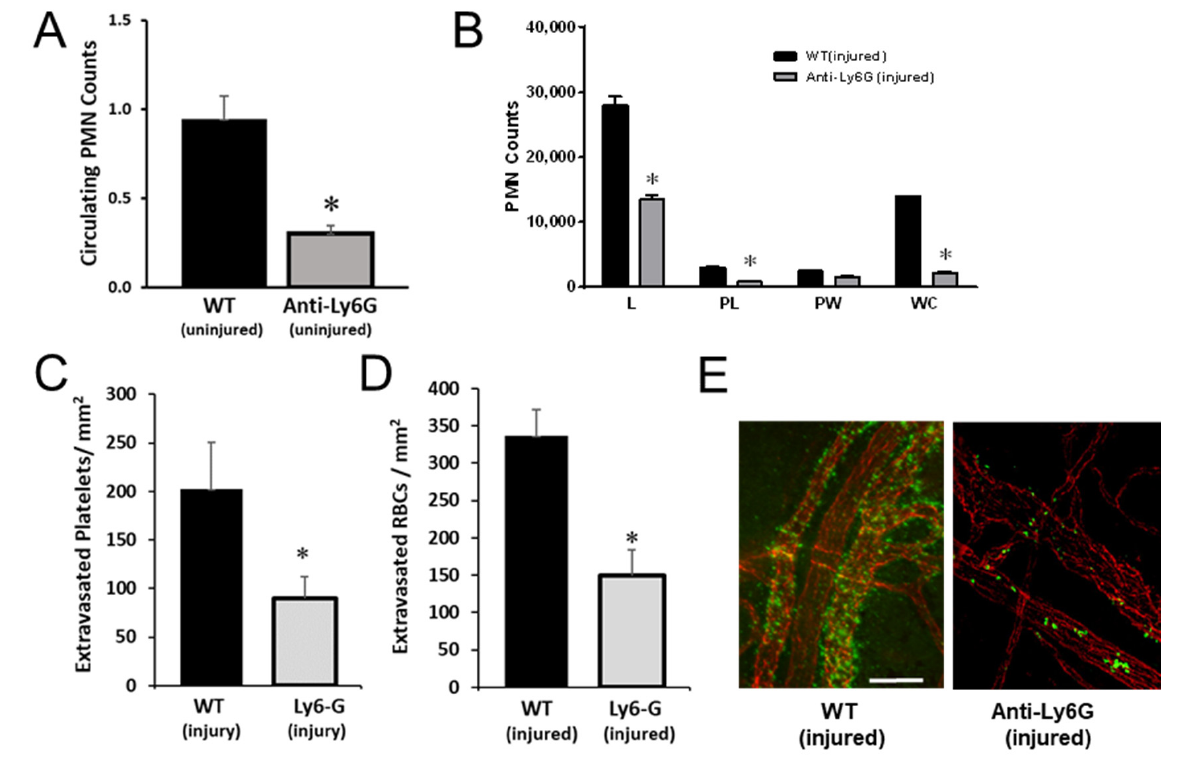
Figure 2. Anti-Ly6G antibody treatment reduces PMN extravasation and platelet and RBC recruitment. ( A ) Absolute circulating PMN counts were reduced in mice 24 h after control antibody WTor anti-Ly6G antibody injection. ( B – E ) Corneas were collected and immunostained 24 h after wounding. ( B ) PMN infiltration across the cornea (L = limbus, PL = paralimbus, PW = parawound, and WC = wound center). ( C ) Data on platelet extravasation at the limbus are plotted. ( D ) Data on extravascular RBCs at the limbus are plotted ( E ). Representative images of platelet (green, anti-CD41) extravasation from limbal venules (red, anti-CD31). n = 6 per group, * p ≤ 0.05 Bar = 40 µm.